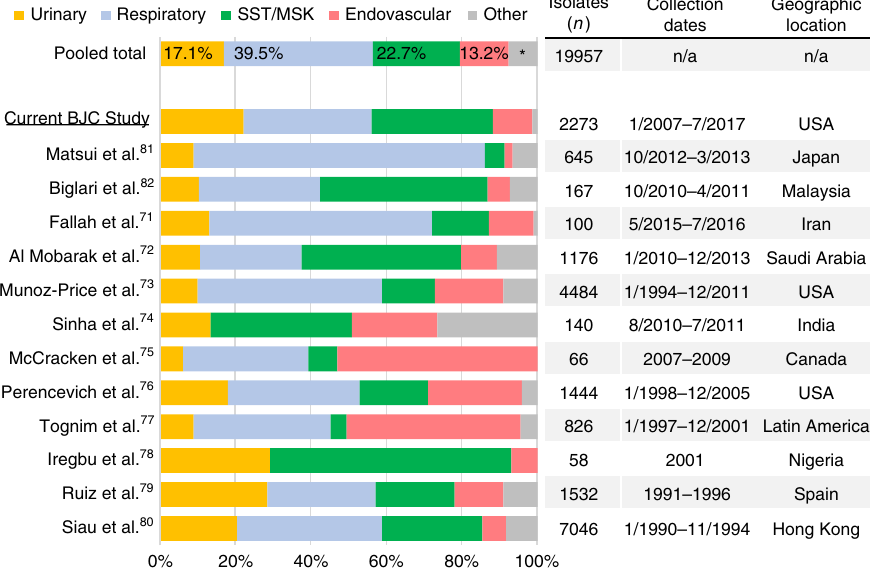
Fig. 1 Urinary tract is an important source of A. baumannii clinical isolates. Graph depicts the distribution of isolates obtained from each anatomical site, listed by study and a “ pooled total ” . Studies included in the analysis are listed on the left axis, with the current study underlined 71 – 82 . Percentage of pooled total isolates corresponding to each anatomical site, is noted in the top-most bar. Table along right axis lists the number of isolates included, the dates of isolate collection, and the country/region where each study was performed. *, “ other ” isolates comprise 7.5% of “ Pooled Total ” isolates. SST/MSK: soft tissue/musculoskeletal. Source data are provided as a Source Data fi Fg-coated catheters 21,22 . UPAB1 co-localized with aggregates of Fg (green fl uorescence) (Fig. 2b, right panel), similar to what has been previously observed in corresponding models with E. fae- calis and MRSA 21,22 . Thus, UPAB1 infects the bladder and the